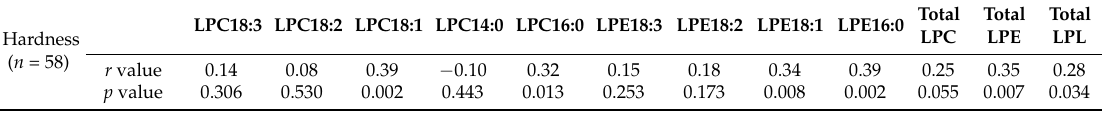
Table 4. Correlation analysis of wheat flour lysophospholipids and wheat kernel hardness (SKCS *).